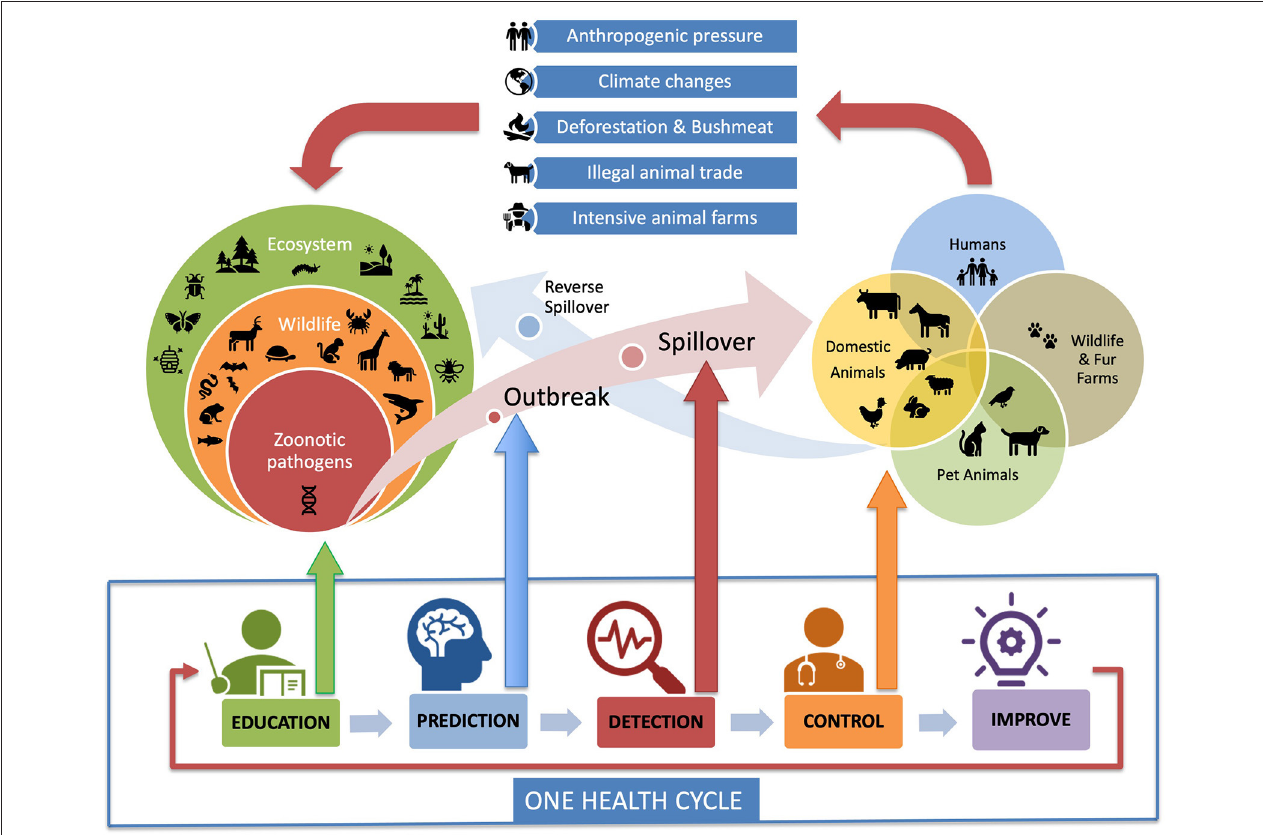
FIGURE 2 | The One Health Cycle explains how the management of a zoonotic pandemic with a One Health approach works. A zoonotic pathogen from wild animals moves into livestock, pets, fur animals, or directly to humans. The One Health approach introduces the processes of “early education” (green) and “early prediction” (blue) that boost the early detection (red) and control (orange) efforts. Early education increases the number of young people able to recognize a zoonosis, while the Artificial Intelligence systems used in early prediction increase the ability to predict an outbreak in wildlife before the spillover can occur. Anthropogenic pressure, deforestation and bushmeat, climate changes, illegal animal trade, and intensive animal farm are all human-generated causal factors causing the emergence and resurgence of zoonotic diseases (Image credit Paolo